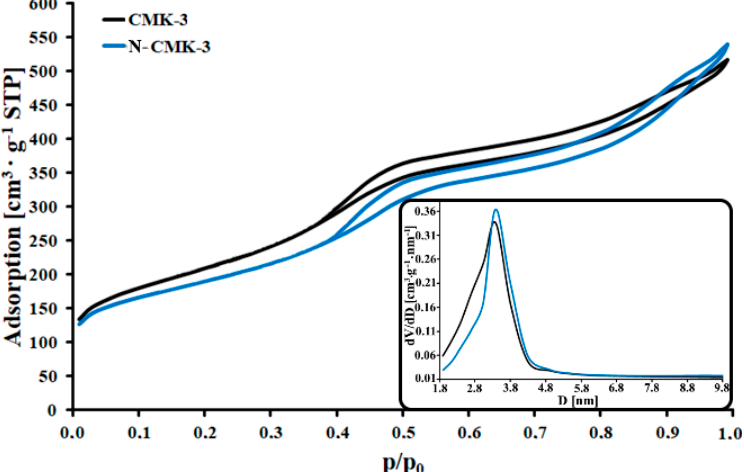
Figure 1. Nitrogen isotherms and pore size distributions (inset) of CMK ‐ 3 and N ‐ CMK ‐ 3. Table 1. Parameters of the porous structure (S BET , V T and d BJH ) obtained from nitrogen isotherms, zeta potential, Raman I D /I G and pH surf. values for both studied samples.